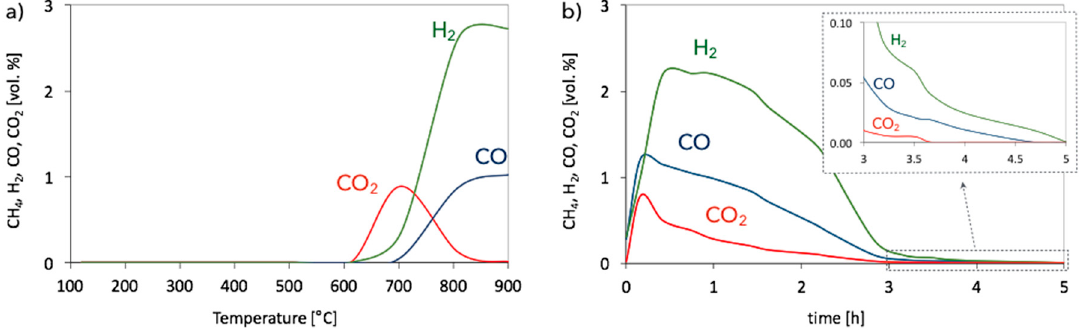
Figure 13. Regeneration of Ni-MgO in 2.8 vol.% H 2 O/Ar in ( a ) temperature programmed conditions and ( b ) at 700 °C.